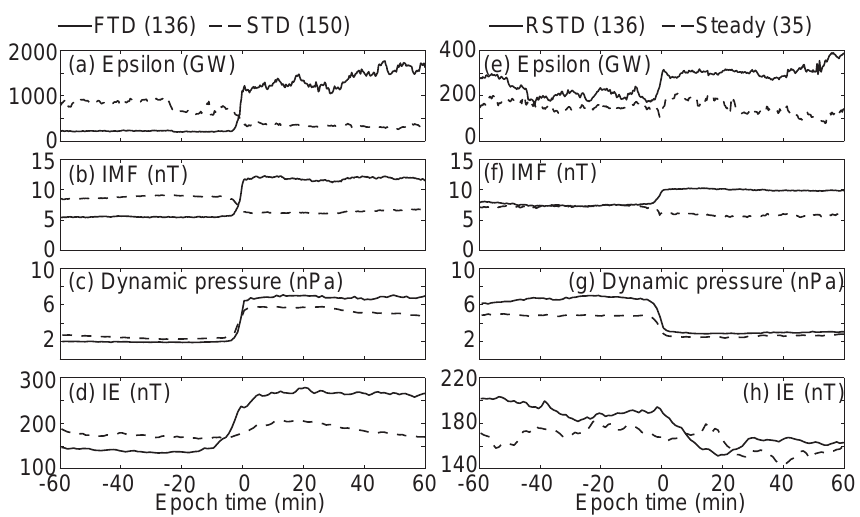
Fig. 4. Left panels: Ionospheric response to 136 fast type (solid) and 150 slow type (dashed) discontinuities during 1998–2004. Superposed epoch averages for (a) Solar wind epsilon, (b) IMF magnitude, (c) solar wind dynamic pressure, and (d) IE index derived from IMAGE magnetometer chain. Right panels: Ionospheric response to 136 sudden negative pressure pulses with a simultaneous increase in the IMF (solid) and 35 steady decompression events (dashed) during 1998-2004. Superposed epoch averages for (e) Solar wind epsilon, (f) IMF magnitude, (g) solar wind dynamic pressure, and (h) IE index derived from IMAGE magnetometer chain.